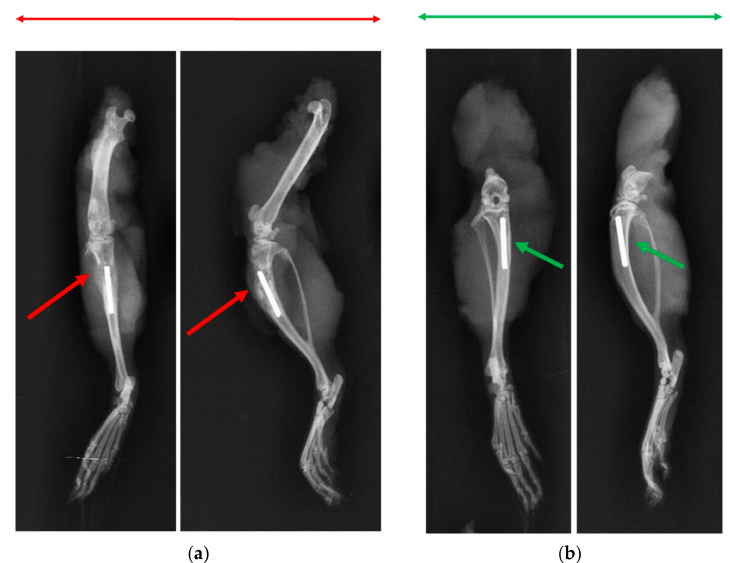
Figure 5. ( a ) The x-ray radiograph of the k-wire rat control group demonstrated signs of osteomyelitis (i.e., osteolysis, periosteal thickening and formation of sequestrum). ( b ) The k-wire treatment group showed no such signs of osteomyelitis and the bone appeared to be healed.